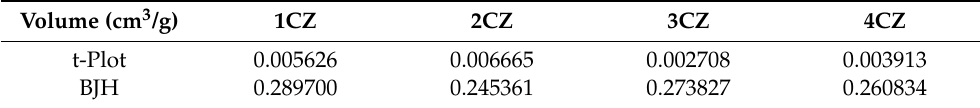
Table 4. t-Plot micropore volume and BJH mesopore volume for the CZ